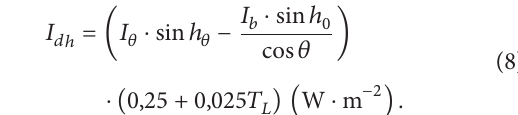
Figure2:Adiagramofsolarradiationincidentonauniversalarea[3,4,8].S,N—cardinalpoints, ℎ 0 —heightoftheSun, 𝜃 —theanglebetween a surface normal and sunbeams, 𝛽 —a tilt angle of collectors area from a horizontal plane, 𝑎 S 𝑎 S —the azimuth of the Sun from the s